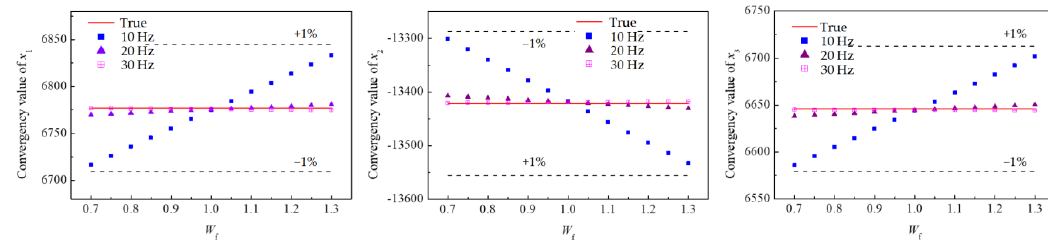
Figure 7. Effects of initial guess on the convergence values of system model parameters.